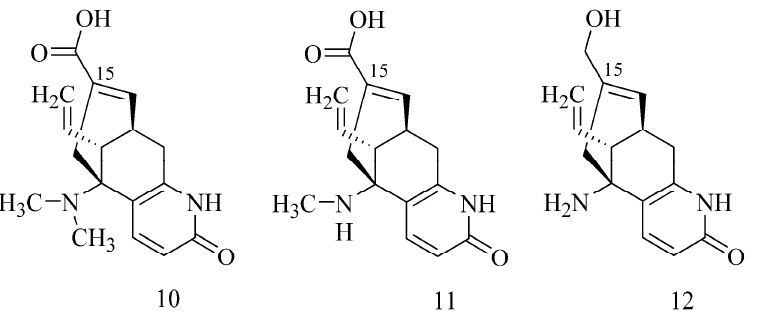
Figure 4. Chemical structures of lycoparin A ( 10 ), lycoparin B ( 11 ) and lycoparin C ( 12 ). Strong inhibitory activity against AChE comparable to that of galanthamine ( 1 ) is demonstrated by indole alkaloids from Ervatamia hainanensis (coronaridine ( 13 ) and voacangine ( 14 )). Due to the presence of the substituent voacangine (14), they have markedly increased AChE inhibition. This is because of the attachment of the methoxyl substituent to the phenyl group, while the substitution of 10-hydroxycoronaridine with a hydroxy group on the phenyl decreases the activity (Table 1) (Figure 5) [25].